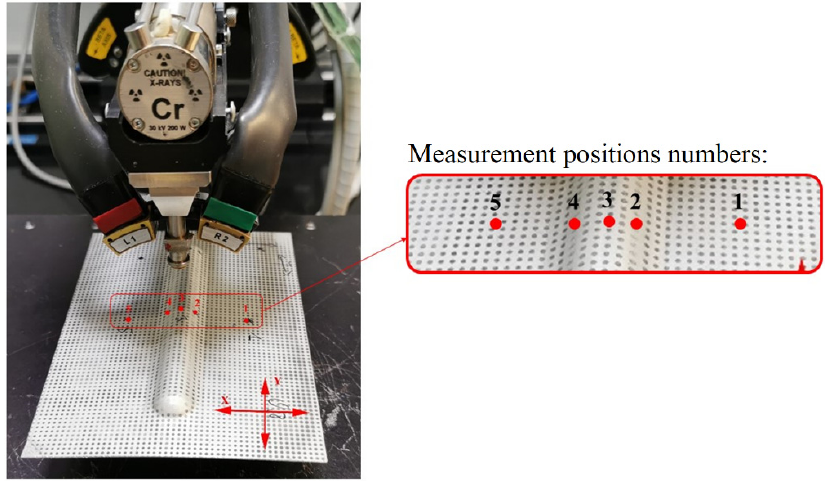
Figure 5. XRD equipment and residual stress corresponding positions 1–5 in LITECOR ® panel.